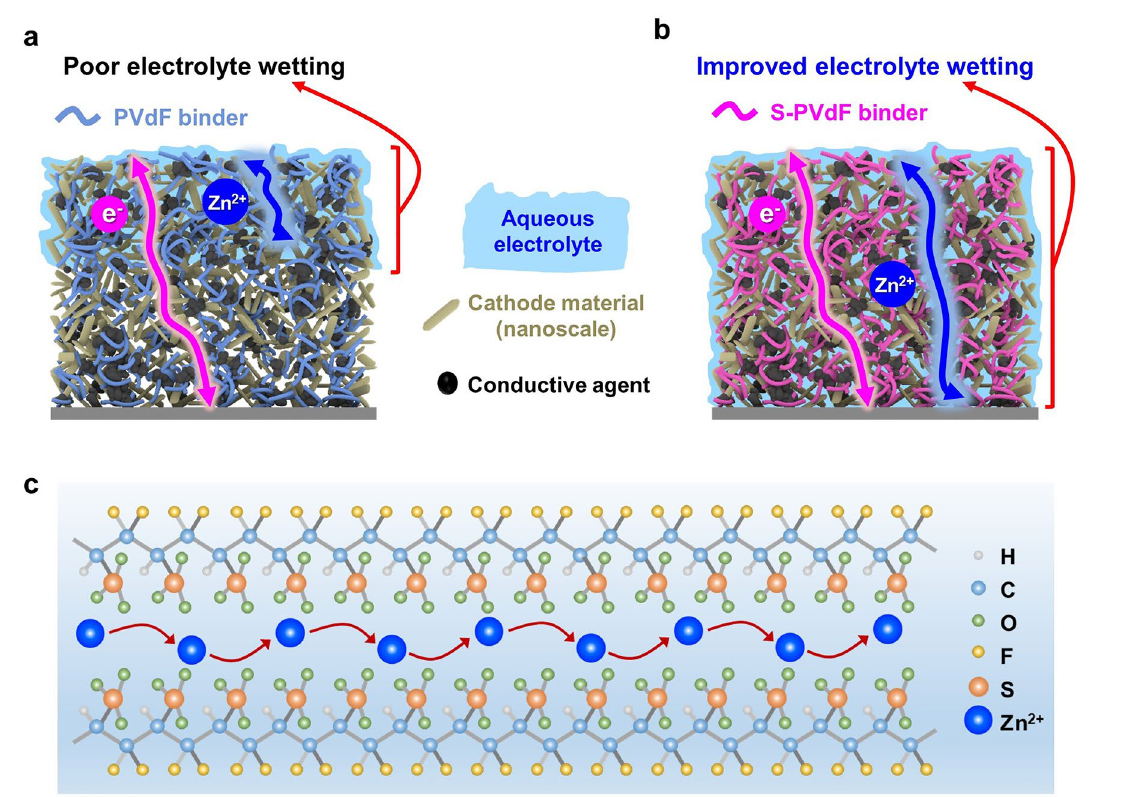
Fig. 1 a Schematic illustrations show the transport limitation of Zn 2+ in a thick electrode with PVdF binders. b Schematic illustrations show the facile transport of Zn 2+ in a thick electrode with S-PVdF binders. c Zn 2+ ion conduction via sulfonate groups in